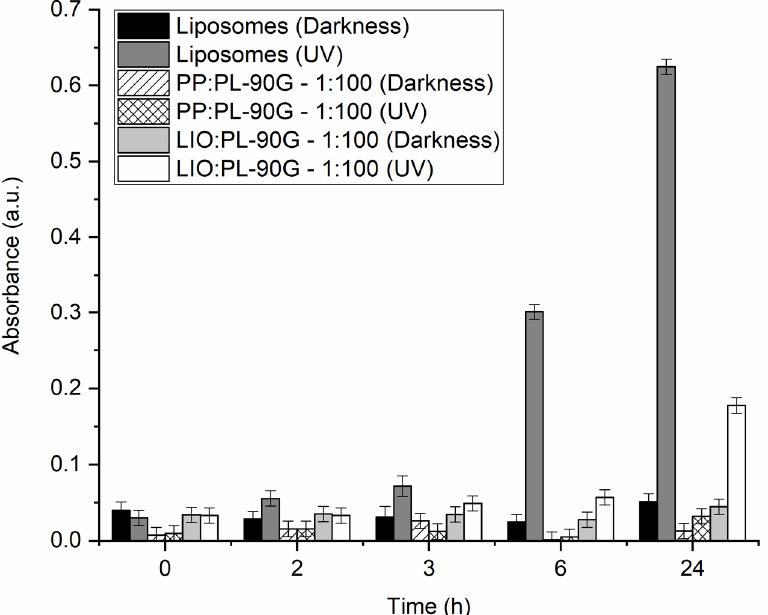
Figure 2. Peroxidation of phospholipon PL-90G (PL-90G) lipids in 20 mM HEPES (pH = 7.0) buffer without (Liposomes) or with the addition of propolis extract (PP) or propolis encapsulated in gum Arabic (LIO) at w PP/PP (LIO) : w PL-90G = 1:100 mass ratio, as obtained by the thiobarbituric acid reactive species (TBARS) assay. Darkness—samples kept in darkness (negative control); UV—samples exposed to ultraviolet light (254 nm).